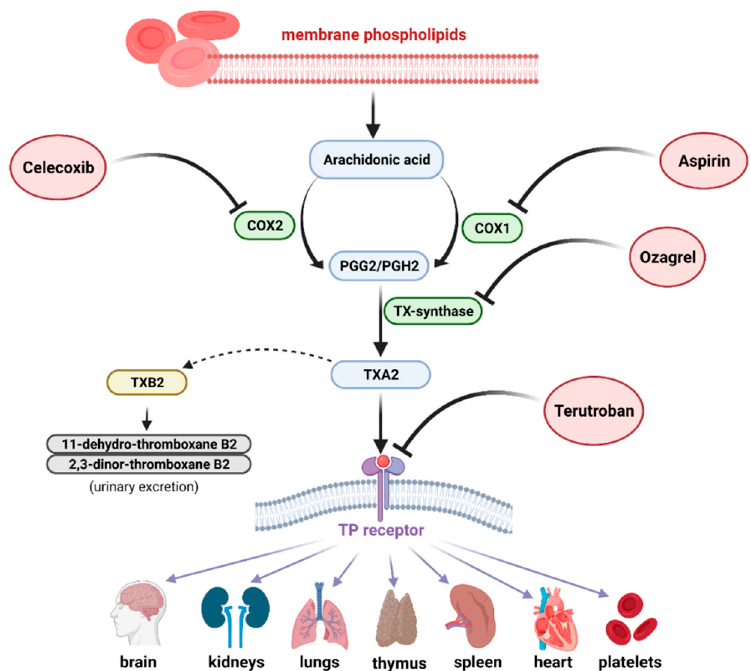
Figure 2. The scheme of action of thromboxane antagonists: aspirin is an inhibitor of cyclooxygenase 1 (COX-1) and celecoxib inhibits COX-2. Ozagrel blocks the conversion of PGH2 to TXA2 by inhibiting thromboxane synthase (TXS). Terutroban (TP antagonists) block the activation of the thromboxane receptor (TP receptor) (created with BioRender.com).